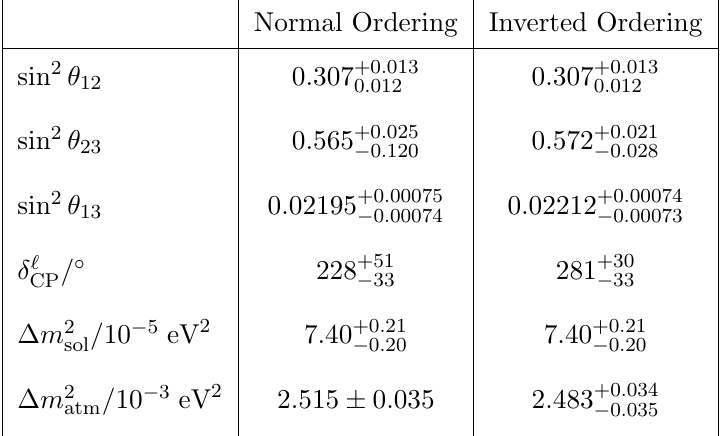
(cid:17) m 2 (cid:0) m 2 and (cid:23) 2 (cid:23) 1 sol